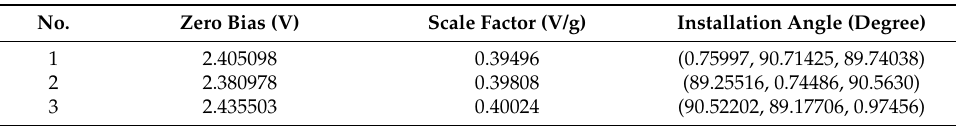
Table 2. Output of tri-accelerometer unit when the accelerometer of the x -axis is ±1 g (unit: g). Sensor